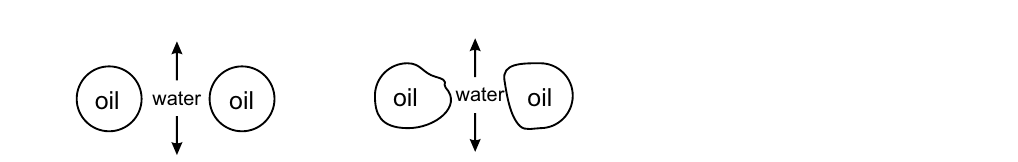
◦ ◦ ◦ C (black squares), 30 C (red circles), 40 C (blue upward triangles),